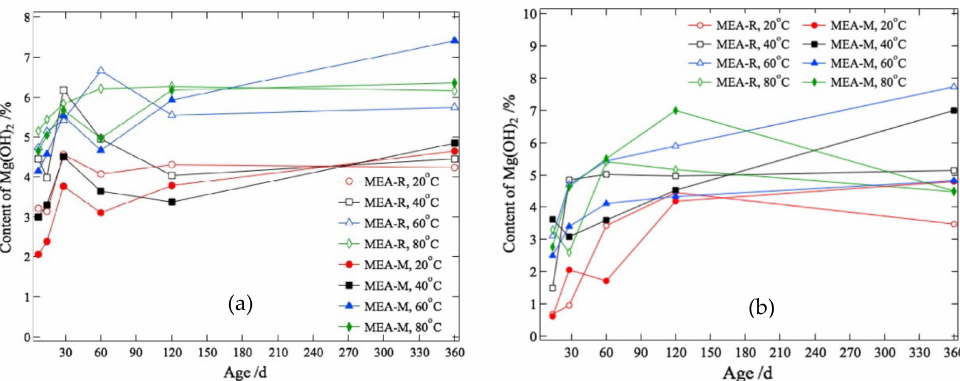
Figure 8. Estimated quantities of Mg(OH) 2 in cement pastes (6 wt% MgO expansive agent) from 20 °C to 80 °C: ( a ) on the basis of DSC/TG; ( b ) on the basis of QXRD (reprinted with permission from Ref. [32], 2019,